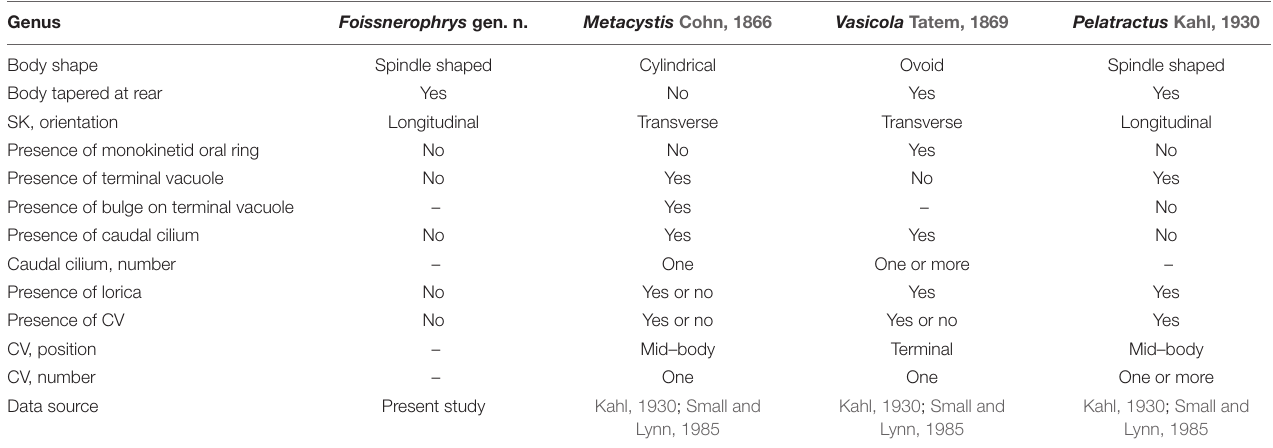
TABLE 3 | Comparison of Foissnerophrys gen. n. with related